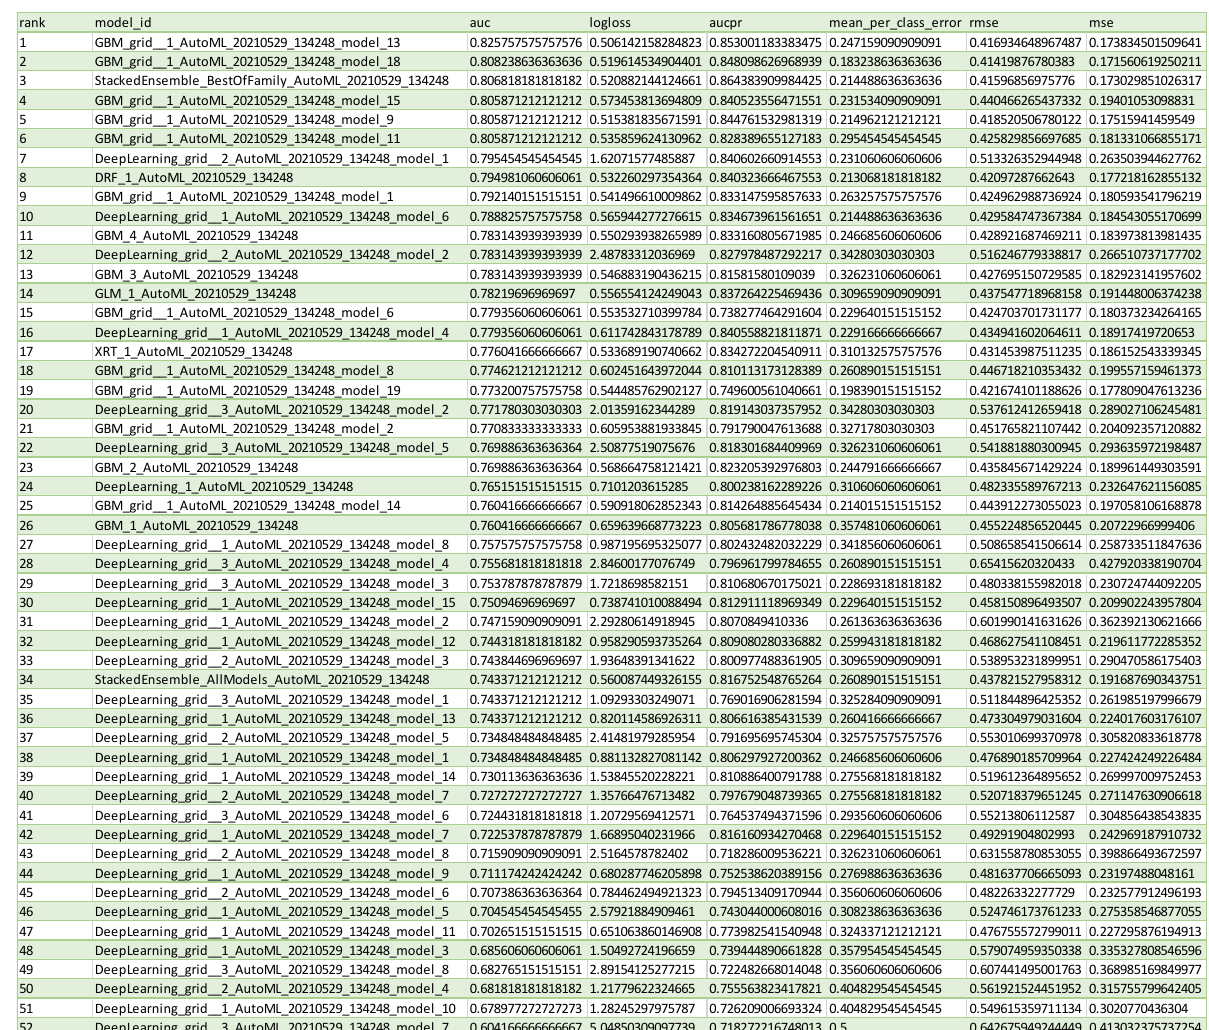
Figure A1. Number of samples for each class. 2-class scenario only used class 0 and 16, while 17 class scenario used all classes. 5 class scenario divided samples as colour coded.